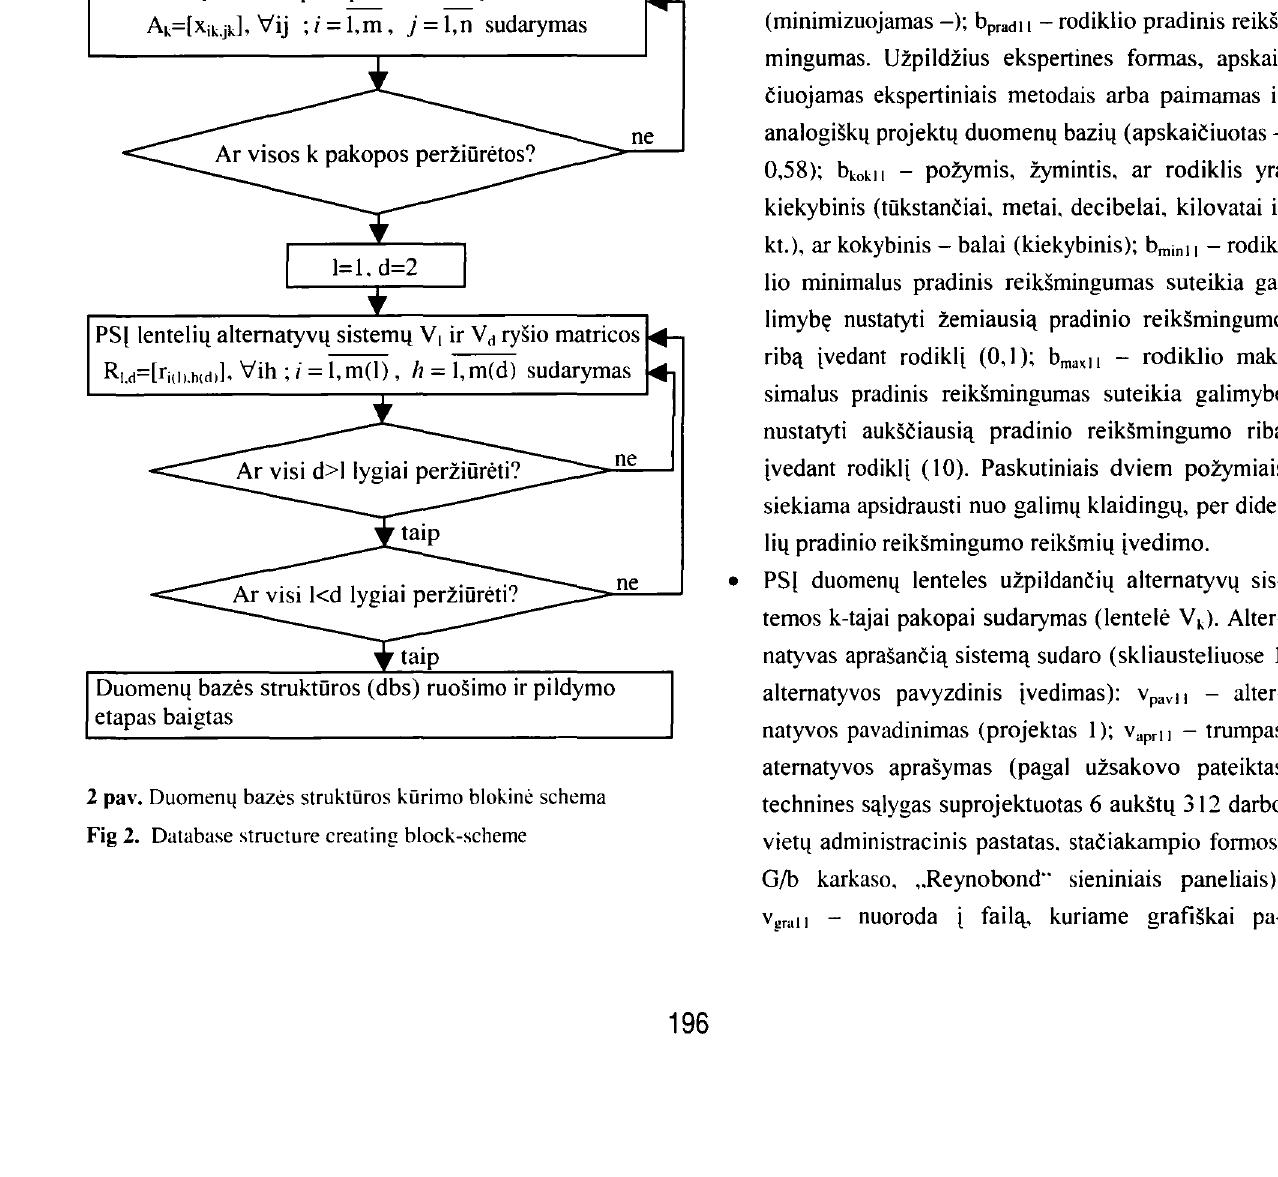
Fig 2. Database structure creating block-scheme